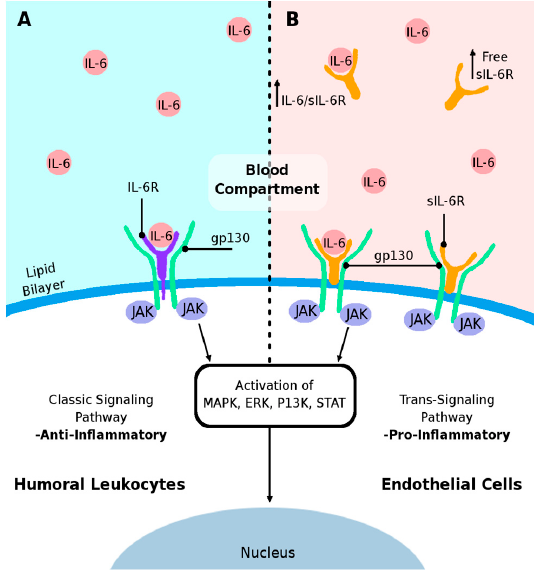
Figure 3. Schematic diagram proposed mechanism of humoral IL-6-mediated inflammation in triggering EC damage. ( A ) The IL-6 cytokine is an important anti-inflammatory protein for regulation of cell survival by binding to the cell membrane receptor IL-6R/gp130 complex leading to activation of JAK, subsequent activation of other signal transduction molecules which influences nuclear gene transcription (down arrow) via the classic signaling pathway; ( B ) Excessive sIL-6R (up arrow) in the blood, resultant of cleavage from the membrane (shedding) or de novo synthesis, could bind to excess IL-6 and form IL-6/sIL-6R/gp130 complex on ECs. This complex formation on the EC membrane would result in the activation of signal transduction kinases and induce a pro-inflammatory response by activating the trans-signaling pathway.